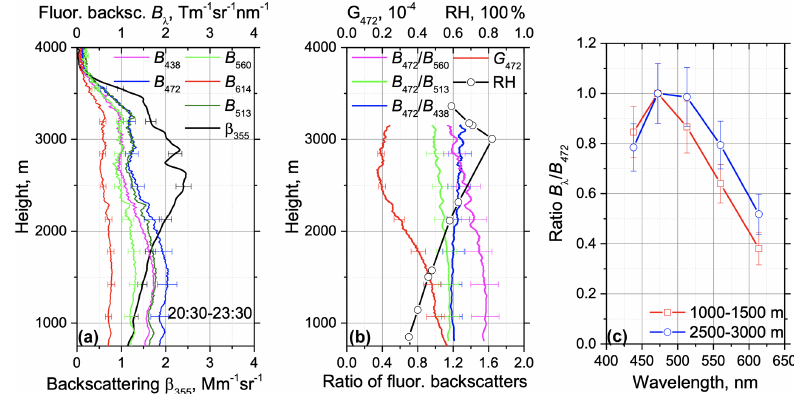
Figure 11. Vertical profiles of the particle parameters on 23 August 2022 for the period 20:30–23:30UTC. (a) The fluorescence-spectral- backscattering coefficients B λ at 438, 472, 513, 560 and 614nm and the aerosol-backscattering coefficient β 355 . (b) The ratios B 472 /B 438 , B 472 /B 513 and B 472 /B 560 and the fluorescence capacity G 472 . Symbols show the relative humidity measured by a radiosonde at 00:00UTC on 24 August. (c) Spectrum of the fluorescence-backscattering coefficient B λ for height intervals of 1000–1500 and 2500–3000m. Values of B λ are normalized according to B 472